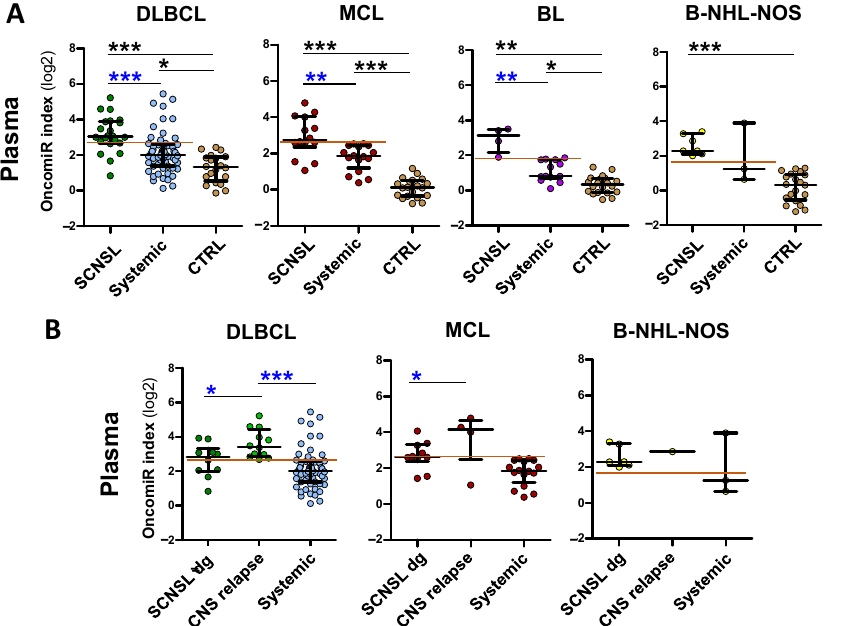
Figure 3. OncomiR indices are increased in plasma of B-NHL involving CNS. OncomiR indices (logistic regression model) combining expression of individual oncomiRs into one classifier in plasma ( A ) of lymphoma patients with indicated B-NHL diagnoses, with (SCNSL) and without secondary CNS involvement (systemic) and control patients (CTRL). ( B ) The SCNSL lymphomas are subdivided into lymphomas with secondary CNS involvement present at diagnosis (SCNSL dg) and newly detected CNS relapses (all BL-SCNSL are from dg). Systemic diagnoses (syst), controls (CTRL). The red line indicates the threshold for positive CNS lymphoma involvement. Log2 scale. Median ± interquartile range, * p < 0.05, ** p < 0.01, *** p < 0.001, Kruskal-Walliss. No star =